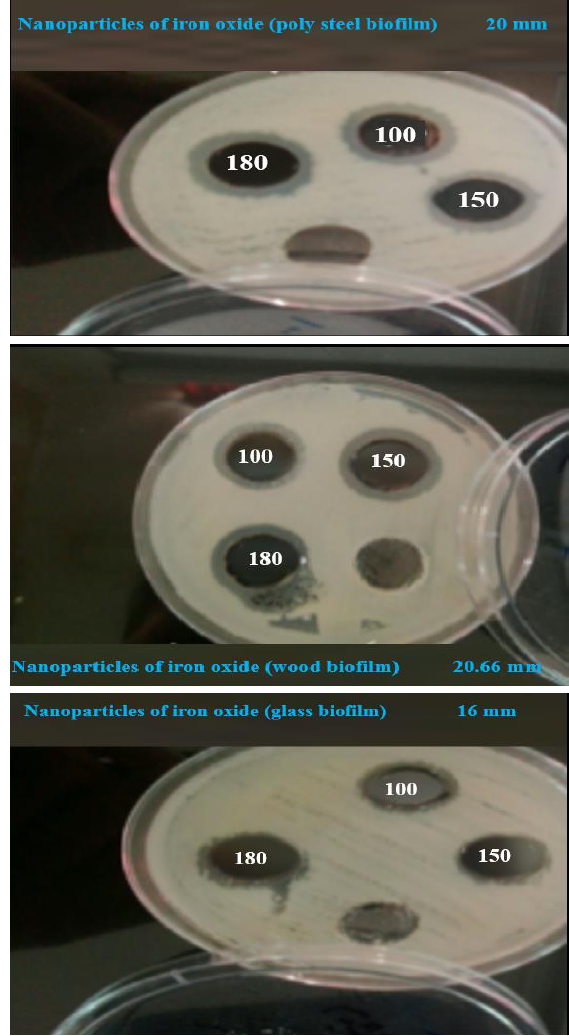
Fig. 4. Results of inoculation of iron oxide nanoparticles in P. aeruginosa biofilm formed on wood, glass, and polysteel surfaces (Numbers shown on arrow of figures show inhibition zone diameter in well with volume of 180 microliters)